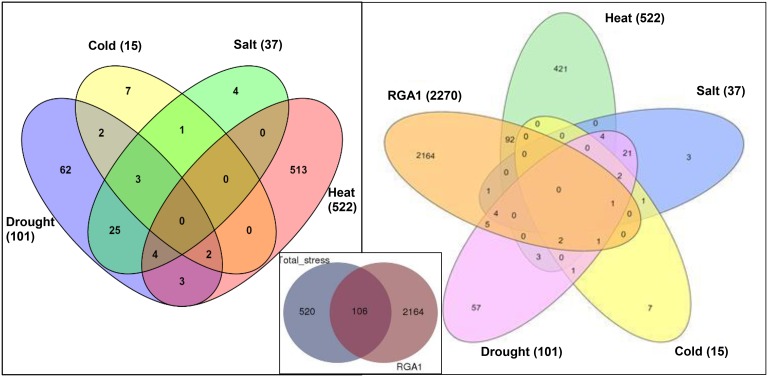
Stress responsive genes among RGA1-regulated genes in rice. The left panel shows Venn selections between the subsets of all rice abiotic stress-responsive genes listed at STIFDB2.0. The inset shows Venn selection between all 626 abiotic stress-responsive genes listed at STIFDB2.0 and 2270 RGA-1-regulated DEGs identified on our microarray. The left panel shows the break-up of the 106 RGA-regulated stress-responsive genes identified in the inset in terms of individual stresses viz., heat (94), drought (13), salt (6), and cold (4).